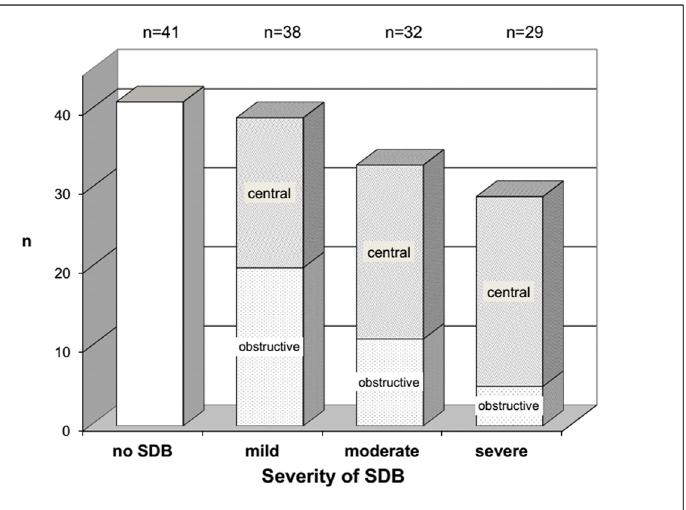
Fig 2. Distribution of sleep disordered breathing. With increasing severity of sleep disordered breathing (SDB), the prevalence of the central subtype increases at the expense of the obstructive subtype of SDB. Severity is indicated by the apnoea-hypopnoea-index: mild 5 – 14.9/h, moderate 15 – 29.9/h, severe >